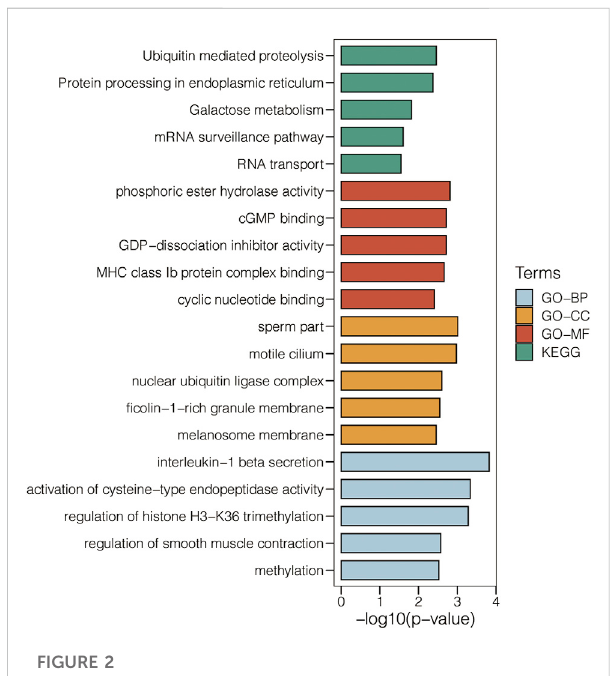
FIGURE 2 Enrichment analysis for GO-BP, GO-CC, GO-MF, and KEGG pathways related to the genes in the turquoise module in